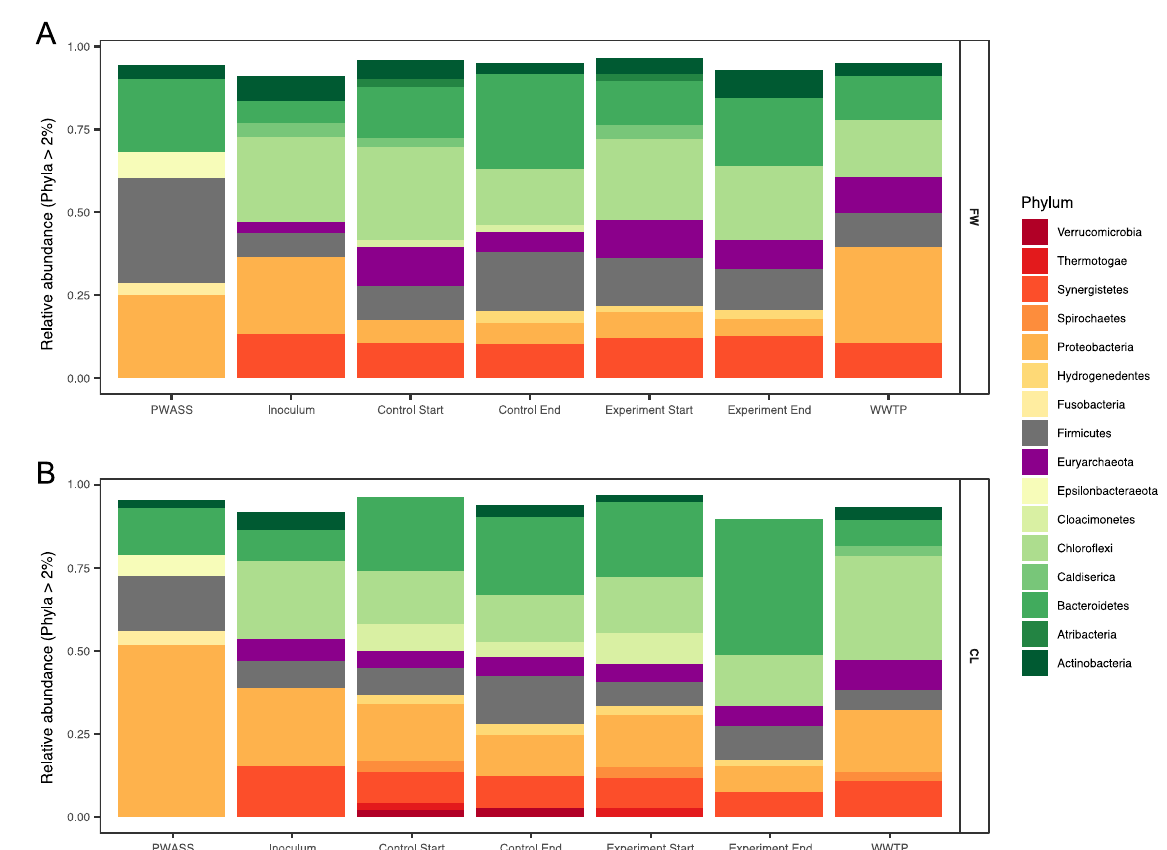
Figure 2. Microbial populations and community composition changes with time and treatment. Phylum-level bar-chart representation of the major taxa (>2% of the total MCC) of the two experiments (( A ) = Food waste, ( B ) = Canola lecithin). A representative raw sludge sample is shown on the very left of each bar plot, followed by the inoculum of the lab-scale reactors on the day of sampling (second from left) and the starting community after 4 weeks in the controls and experimental reactors (3rd, and 4th from left, respectively) and the MCC at the end of the sampling period (3rd last and 2nd last from the left). The last column represents the MCC of the full-scale WWTP AD at a timepoint corresponding to the end of the respective experiment.